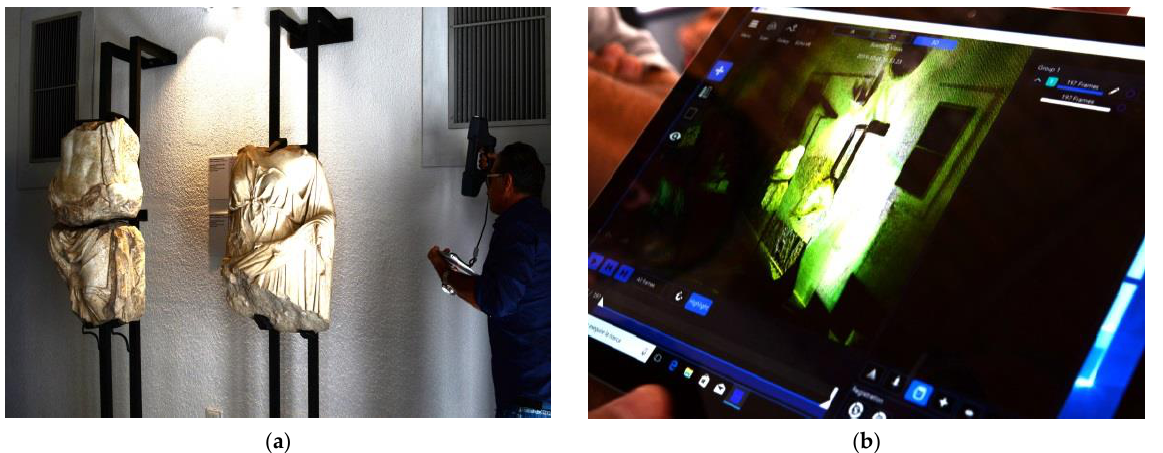
Figure 6. 3D laser scanner survey of the Aesculapius and Hygeia statues: ( a ) Stonex F6 acquisition; ( b ) real-time visualization. Table 1. Details of the photogrammetric survey of the Special Finds. Special Finds N. of Images Focal Length